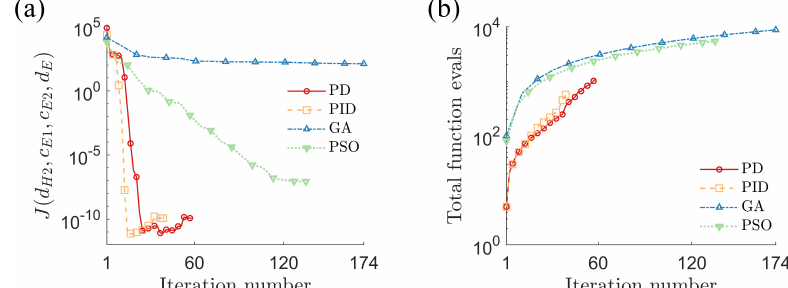
Figure 7. Performance of four strategies to identify parameters for hydraulic engine mount system: ( a ) error convergence of objective function J ( d H 2 , c E 1 , c E 2 , d E ) ; ( b ) computational effort required (cumulative number of function